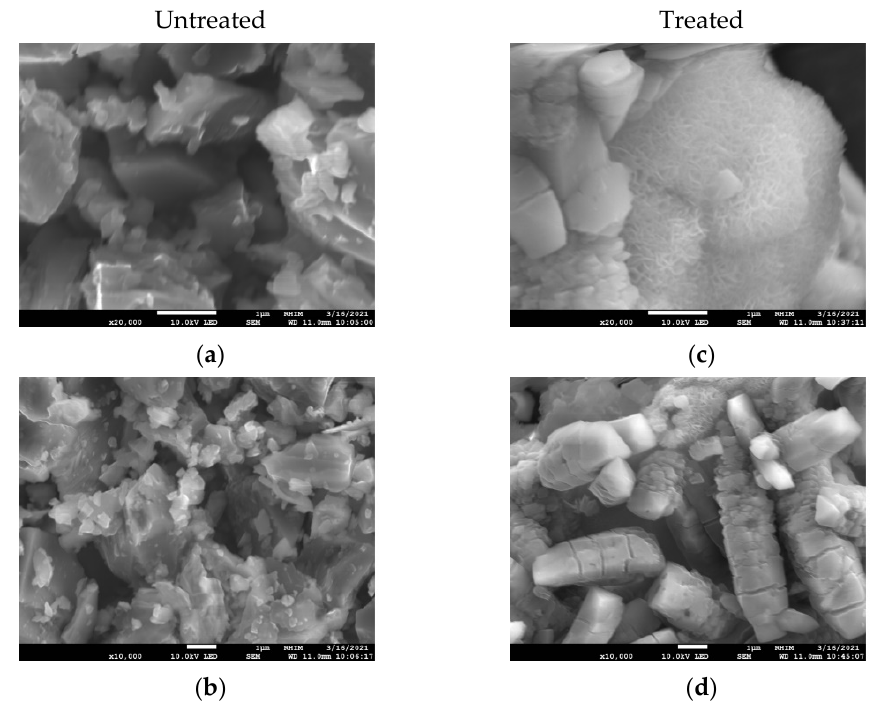
Figure 3. SEM pictures of the untreated ( a , b ) Al 4 C 3 powders and the powder samples after autoclave